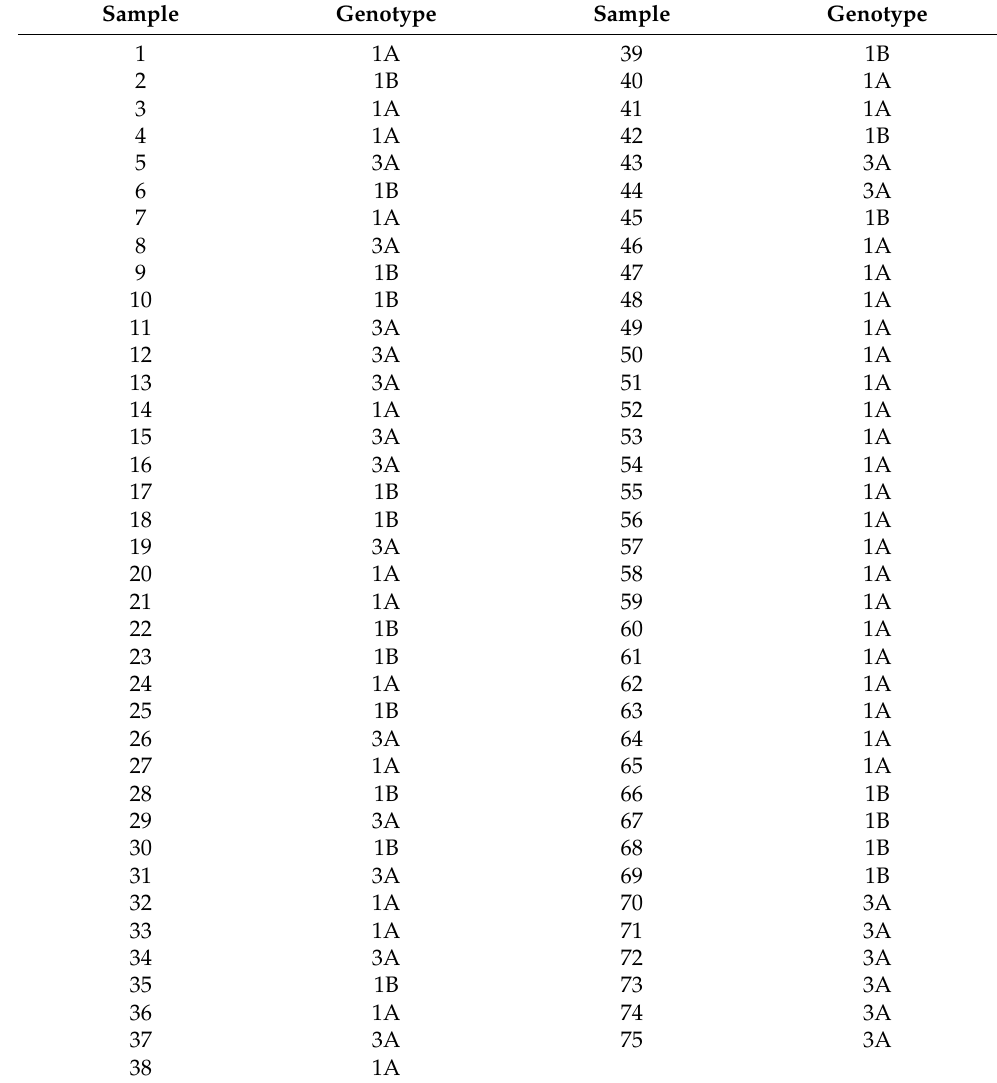
Table 3. Hepatitis A genotype of IgM-positive serum